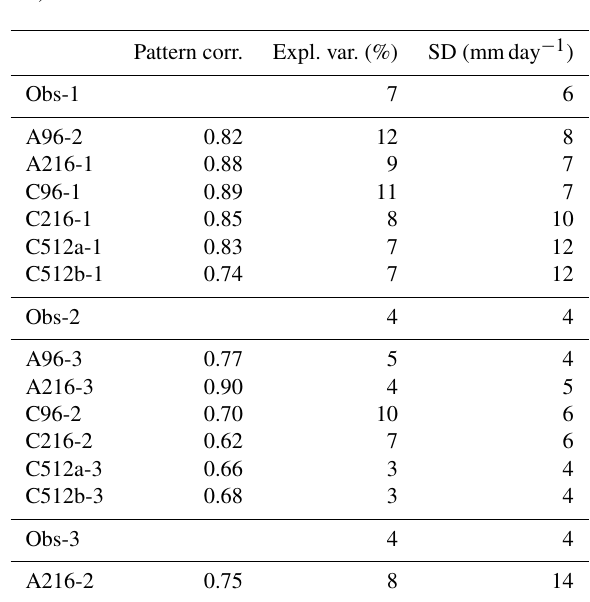
Figure 4. July 500hPa height in the western North Pacific region for 1982–2007 ERA-Interim (a) and the full length of each simulation (b–g) . Lines show the ridge position in June (solid), July (dotted), and August (dashed). All data were first interpolated to a 2 ◦ × 2 ◦ latitude–longitude grid.